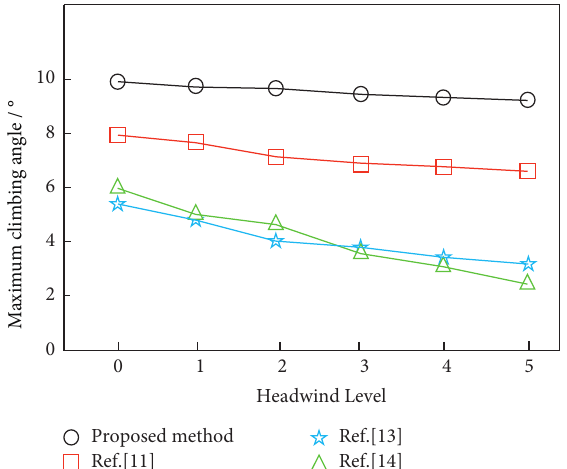
Figure 10: The relationship between the maximum climbing angle of different robots and the headwind level.